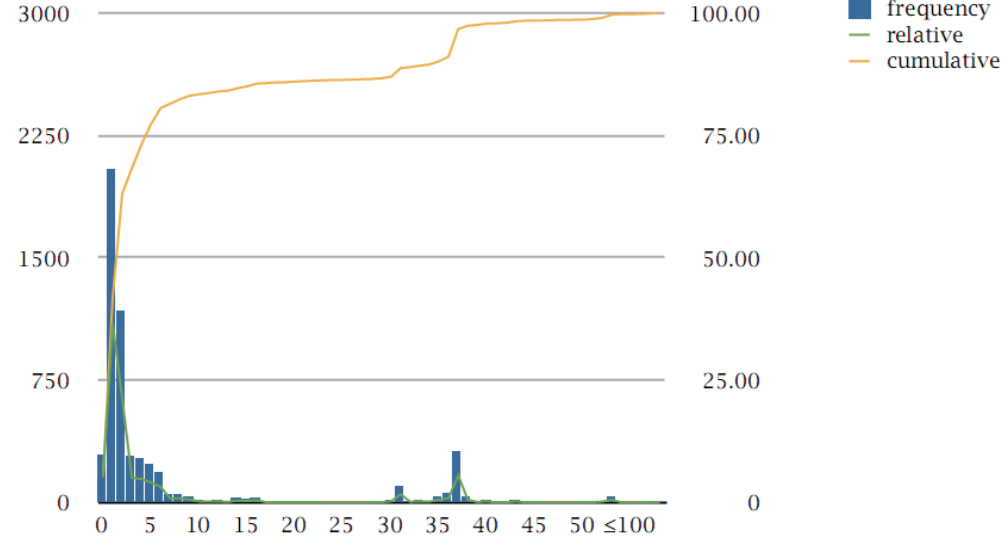
Figure 1. Pangenome protein family size distribution. Cluster size is displayed on the x-axis (bins until 50 are all shown; above 50, bins are shown for each ten counts, labels for every five bin sizes); absolute frequency of clusters is shown on the left y-axis (bars, green curve); cumulative count of clusters is shown on the right y-axis (orange curve). Families are defined as those clusters with at least three members (see text); all cluster frequencies are shown here for completeness. The bimodal nature of the distribution can be seen between the peak at low cluster sizes and 37; above 37 there are multi-member and multi-species protein families (see